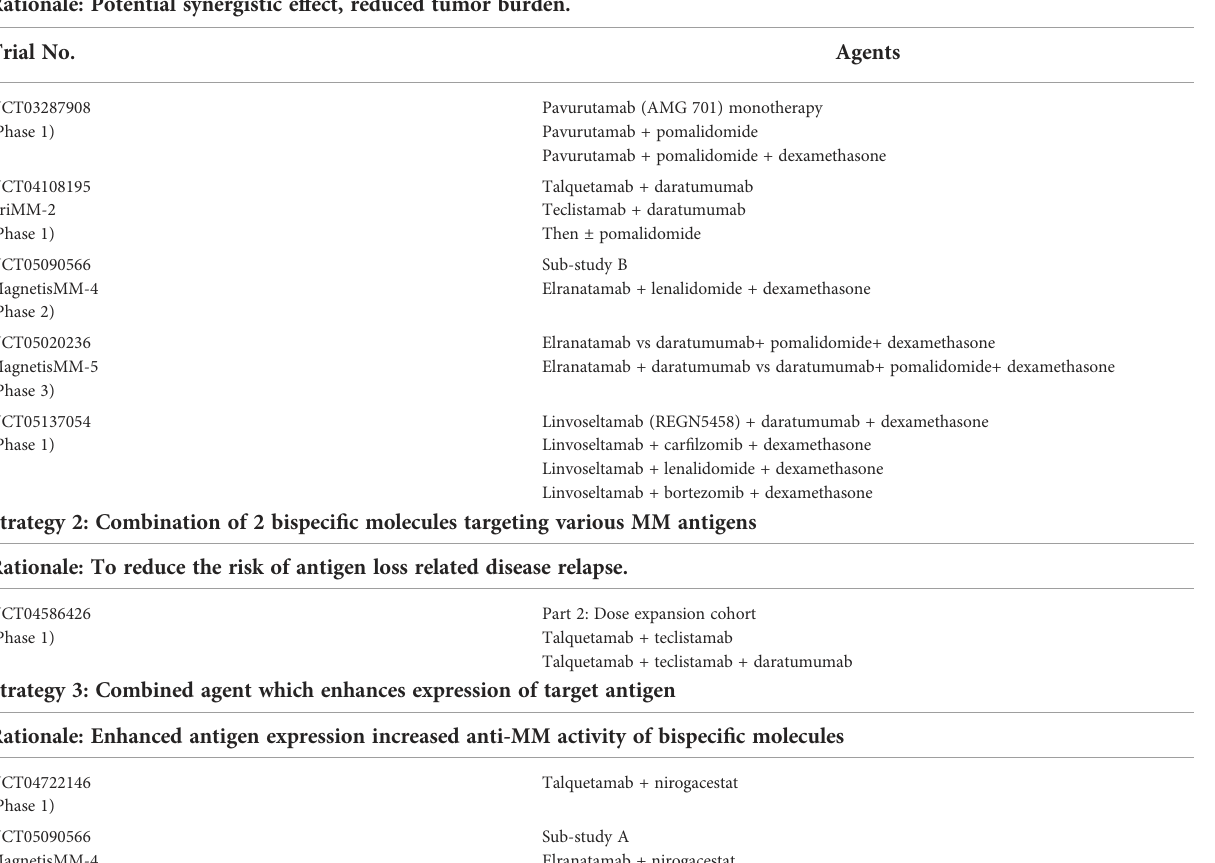
TABLE 3 Summary of combination strategies of bispeci fi c antibodies in clinical trials. Strategy 1: Combination with other anti-myeloma agents Rationale: Potential synergistic effect, reduced tumor burden. Trial No.